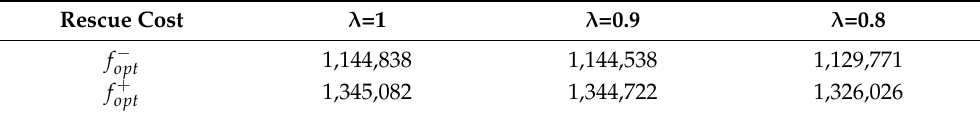
Table 7. The upper and lower bounds of the total cost under different confidence levels (CNY).